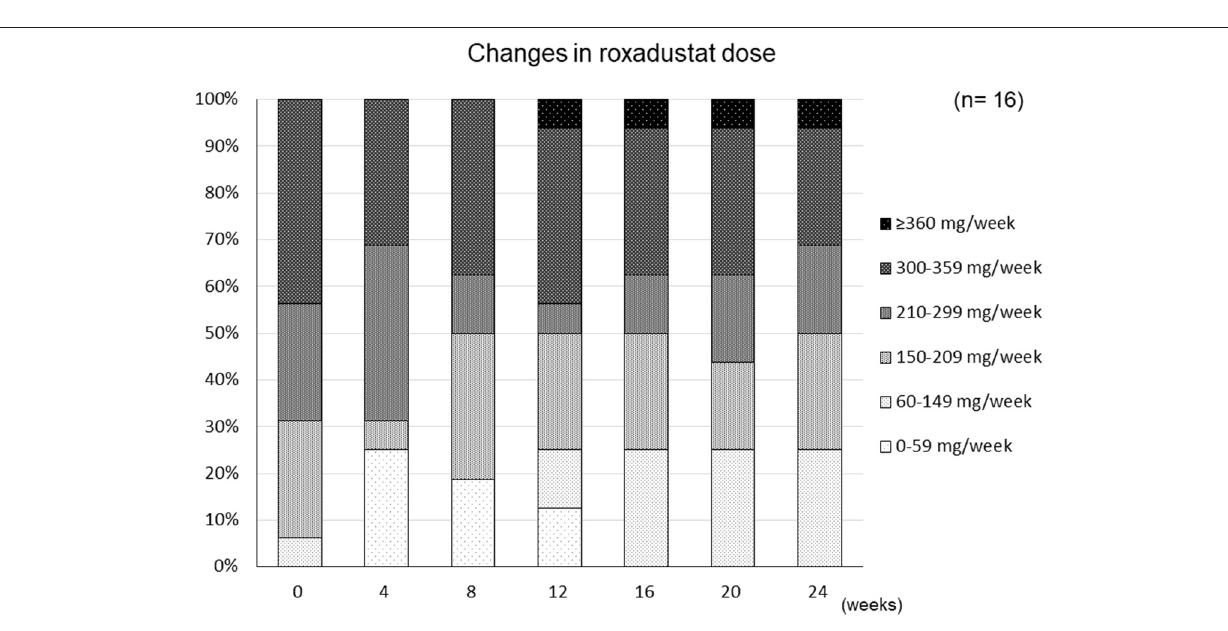
the mean erythropoietin resistance index was 8.7 ± 4.4. Thirty- one patients (79.5%) were undergoing continuous ambulatory peritoneal dialysis (CAPD), 24 patients (61.5%) were undergoing automated peritoneal dialysis (APD), and 16 patients (41.0%) were undergoing a combination of CAPD and